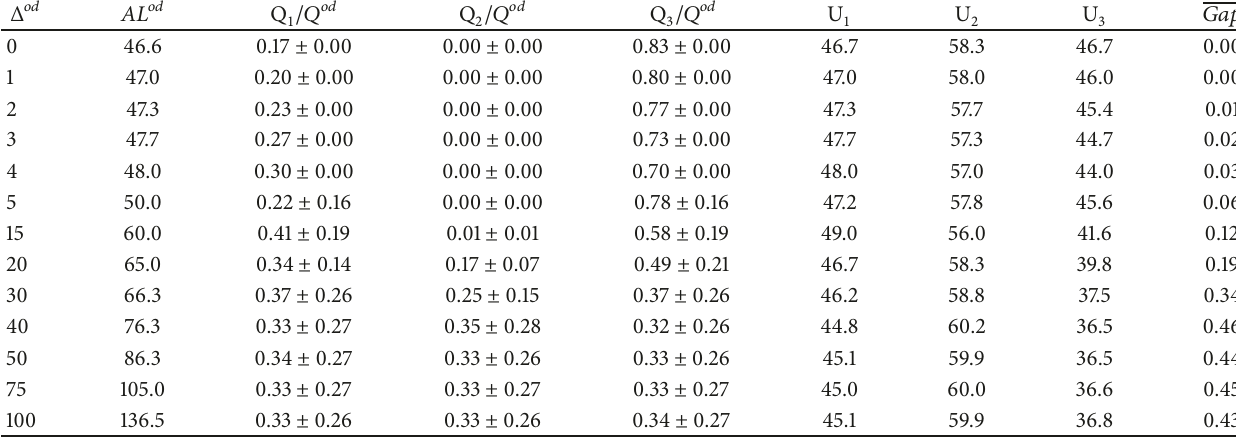
Table 2: BR-DUE route flows for different values of the 𝐴𝐿 𝑜𝑑 . The Gap values represent average values based on 1000 repetitions of the BR-DUE calculations.